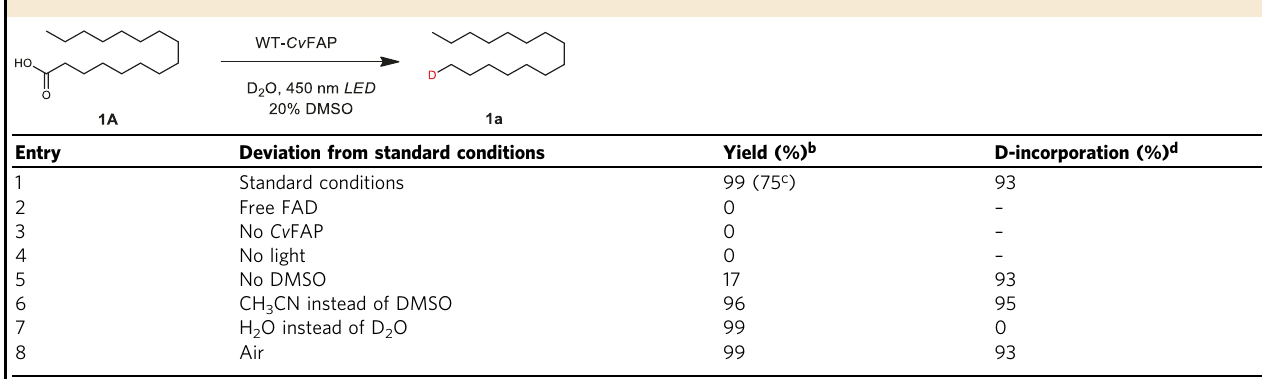
Table 1 Reaction optimization and control experiments a .